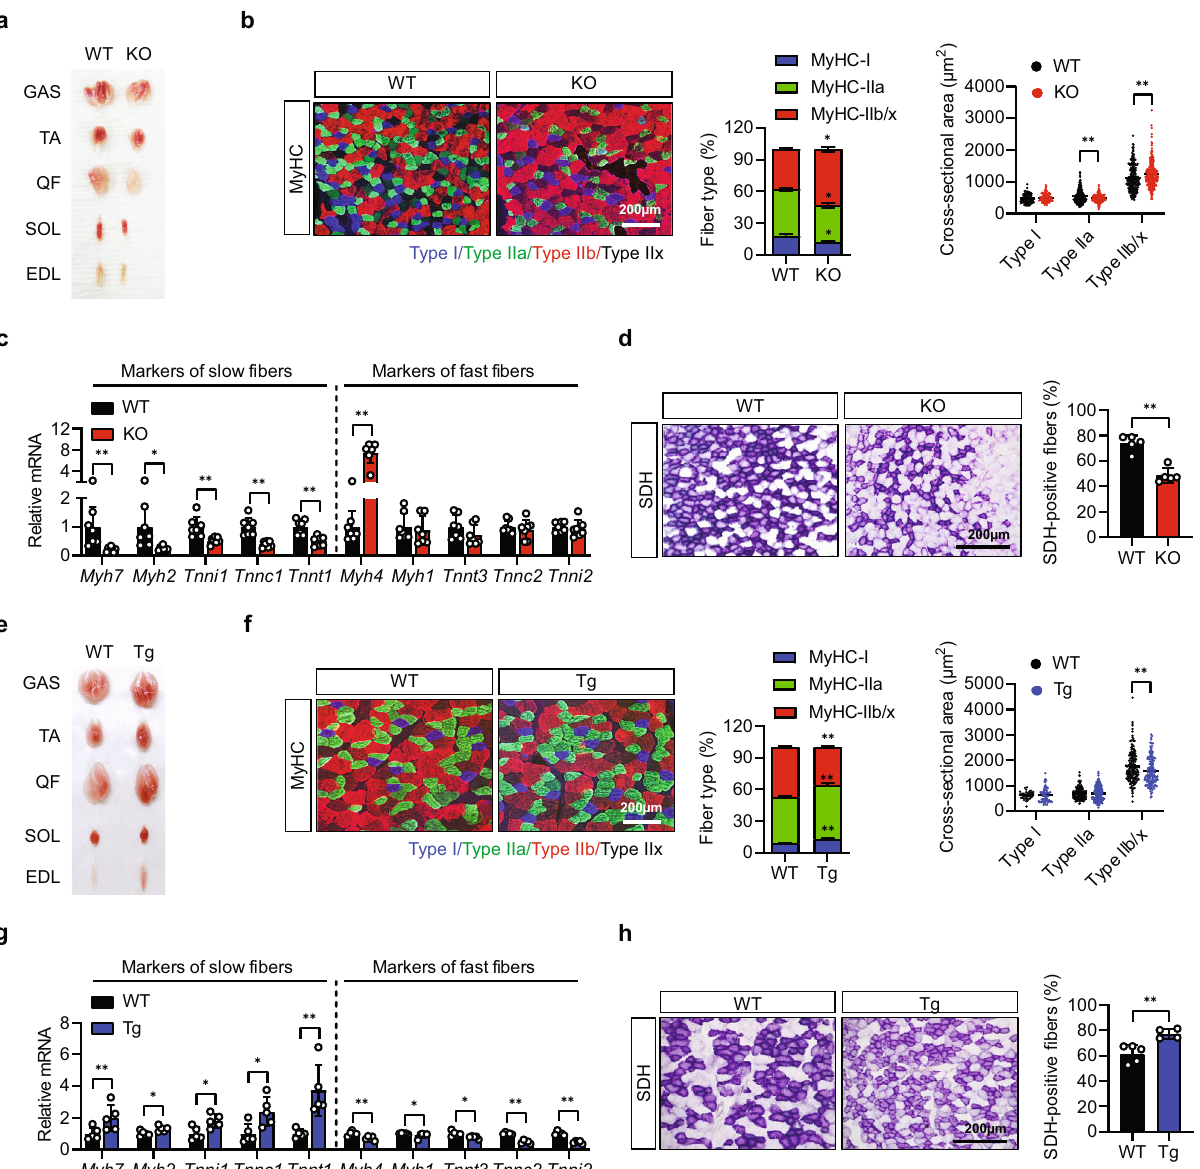
Fig. 2 Alteration of myo fi ber composition in gastrocnemius muscle of Sirt6 KO and Sirt6 Tg mice at basal condition. a , e Representative photographs showing skeletal muscles from 20-week old WT and Sirt6 KO mice or 15-week old WT and Sirt6 Tg mice. b , f Representative immuno fl uorescence staining for MyHC-I, MyHC-IIa, and MyHC-IIb/x. Composition and cross-sectional area (CSA) of each myo fi ber were quanti fi ed ( n = 6 for ( b ), n = 4 – 6 for ( f )). Bar = 200 μ m. c , g Expression of markers of slow and fast fi bers was compared by qPCR ( n = 7 for ( c ), n = 5 for ( g )). d , h Representative succinate dehydrogenase (SDH) staining and quanti fi cation of SDH-positive fi bers ( n = 5 for ( d ), n = 4 – 5 for ( h )). Bar = 200 μ m. ( a – d ) WT and Sirt6 KO mice, ( e – h ) WT and Sirt6 Tg mice. Values are mean ± SEM. Data are representative of at least three independent experiments. Unpaired two-tailed t test between two groups was conducted for statistical analyses ( b – d , f – h ). * p < 0.05 and ** p < 0.01. Source data are provided as a Source Data fi